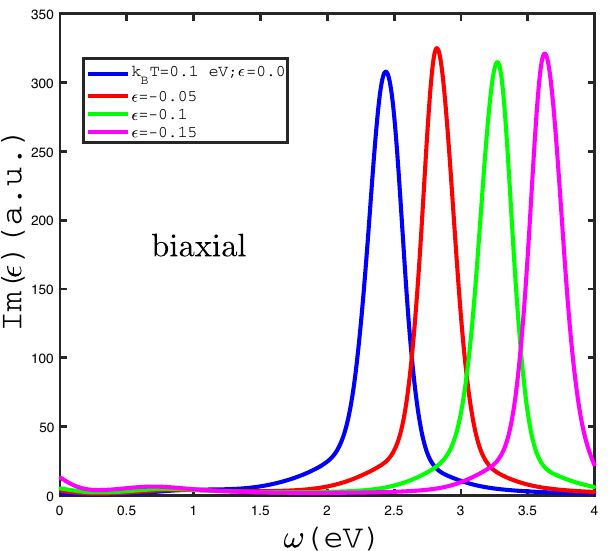
Figure 9. Optical absorption, Im (ǫ) , of undoped MoS 2 layer as a function of photon frequency in the presence of negative biaxial strain for different strain parameter , namely ε x absence of magnetic field at fixed temperature k B T